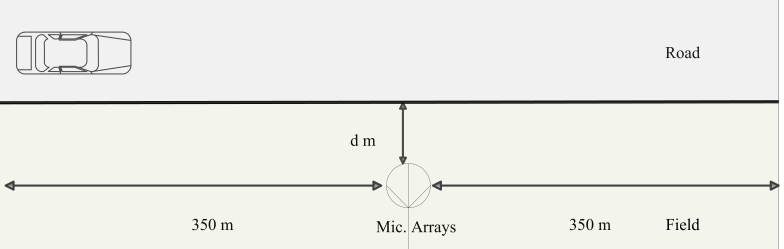
Figure 3. The recording scene. Table 1. The dataset